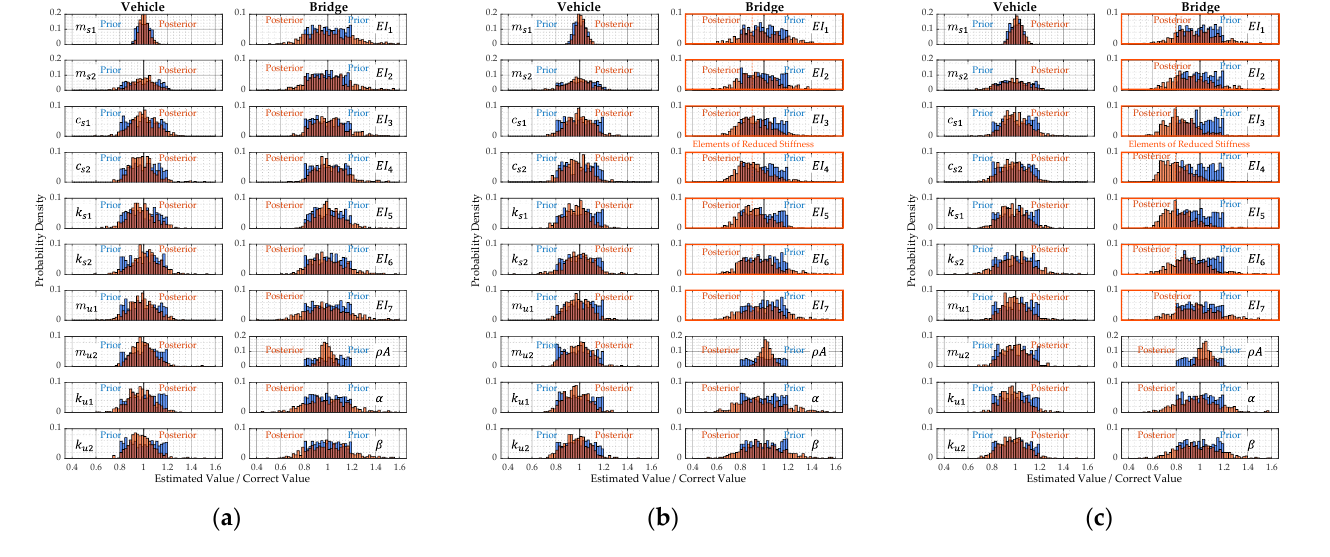
Figure 13. The application results of the PRE method: ( a ) Scenario 1; ( b ) Scenario 2 (stiffness decrease section: 0~ L , decrease ratio: 10%); and ( c ) Scenario 3 (stiffness decrease section: 0~ L , decrease ratio: 20%).